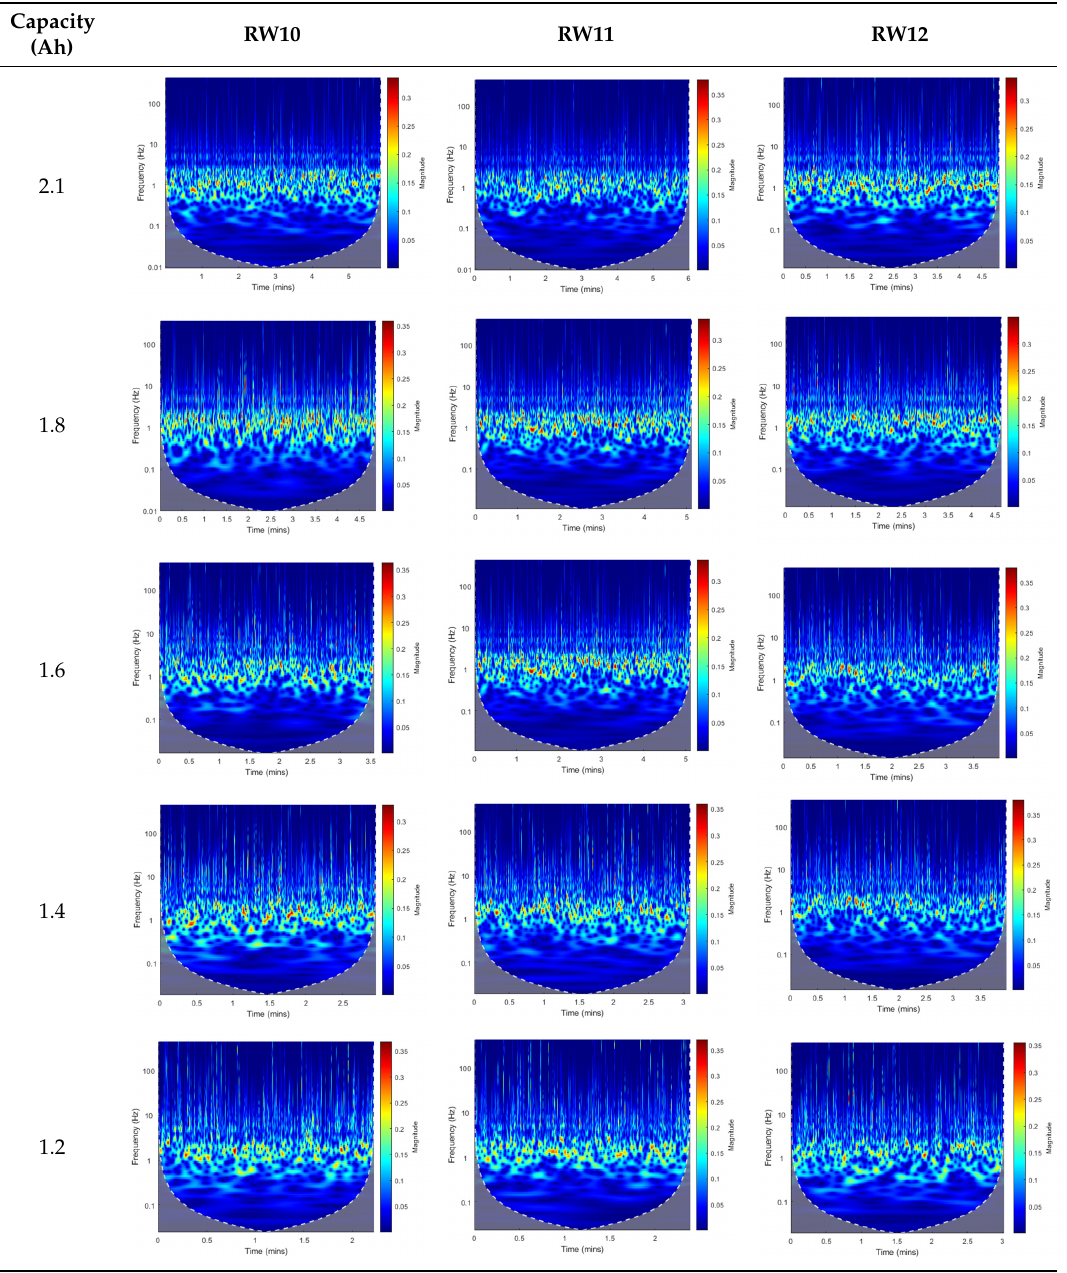
Table 2. TFIs energy concentration spectrum results of RW10, RW11, and RW12 LIBs measured voltage at di ff erent